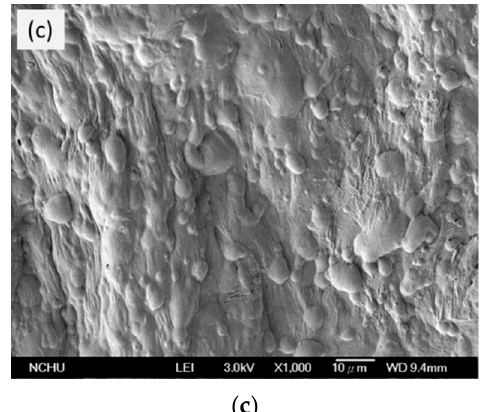
Figure 7. SEM images of char residues after burning: ( a ) Si-PU; ( b ) Si-PU/MPP 30% and ( c ) Si-PU/OFMPP 30%.